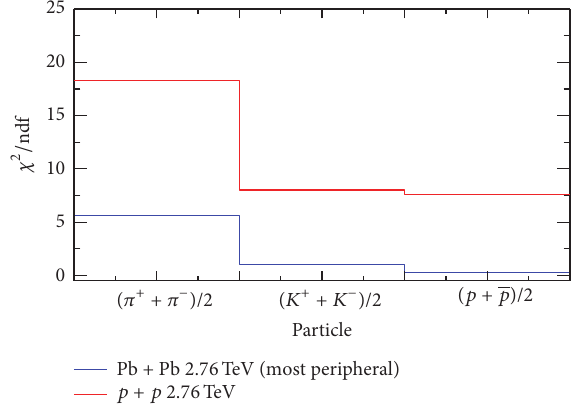
Figure 7: 𝜒 2 / ndf values are shown for most peripheral Au + Au collision and 𝑝 + 𝑝 collisions at √𝑠 NN = 200GeV using (8) as a fit function.